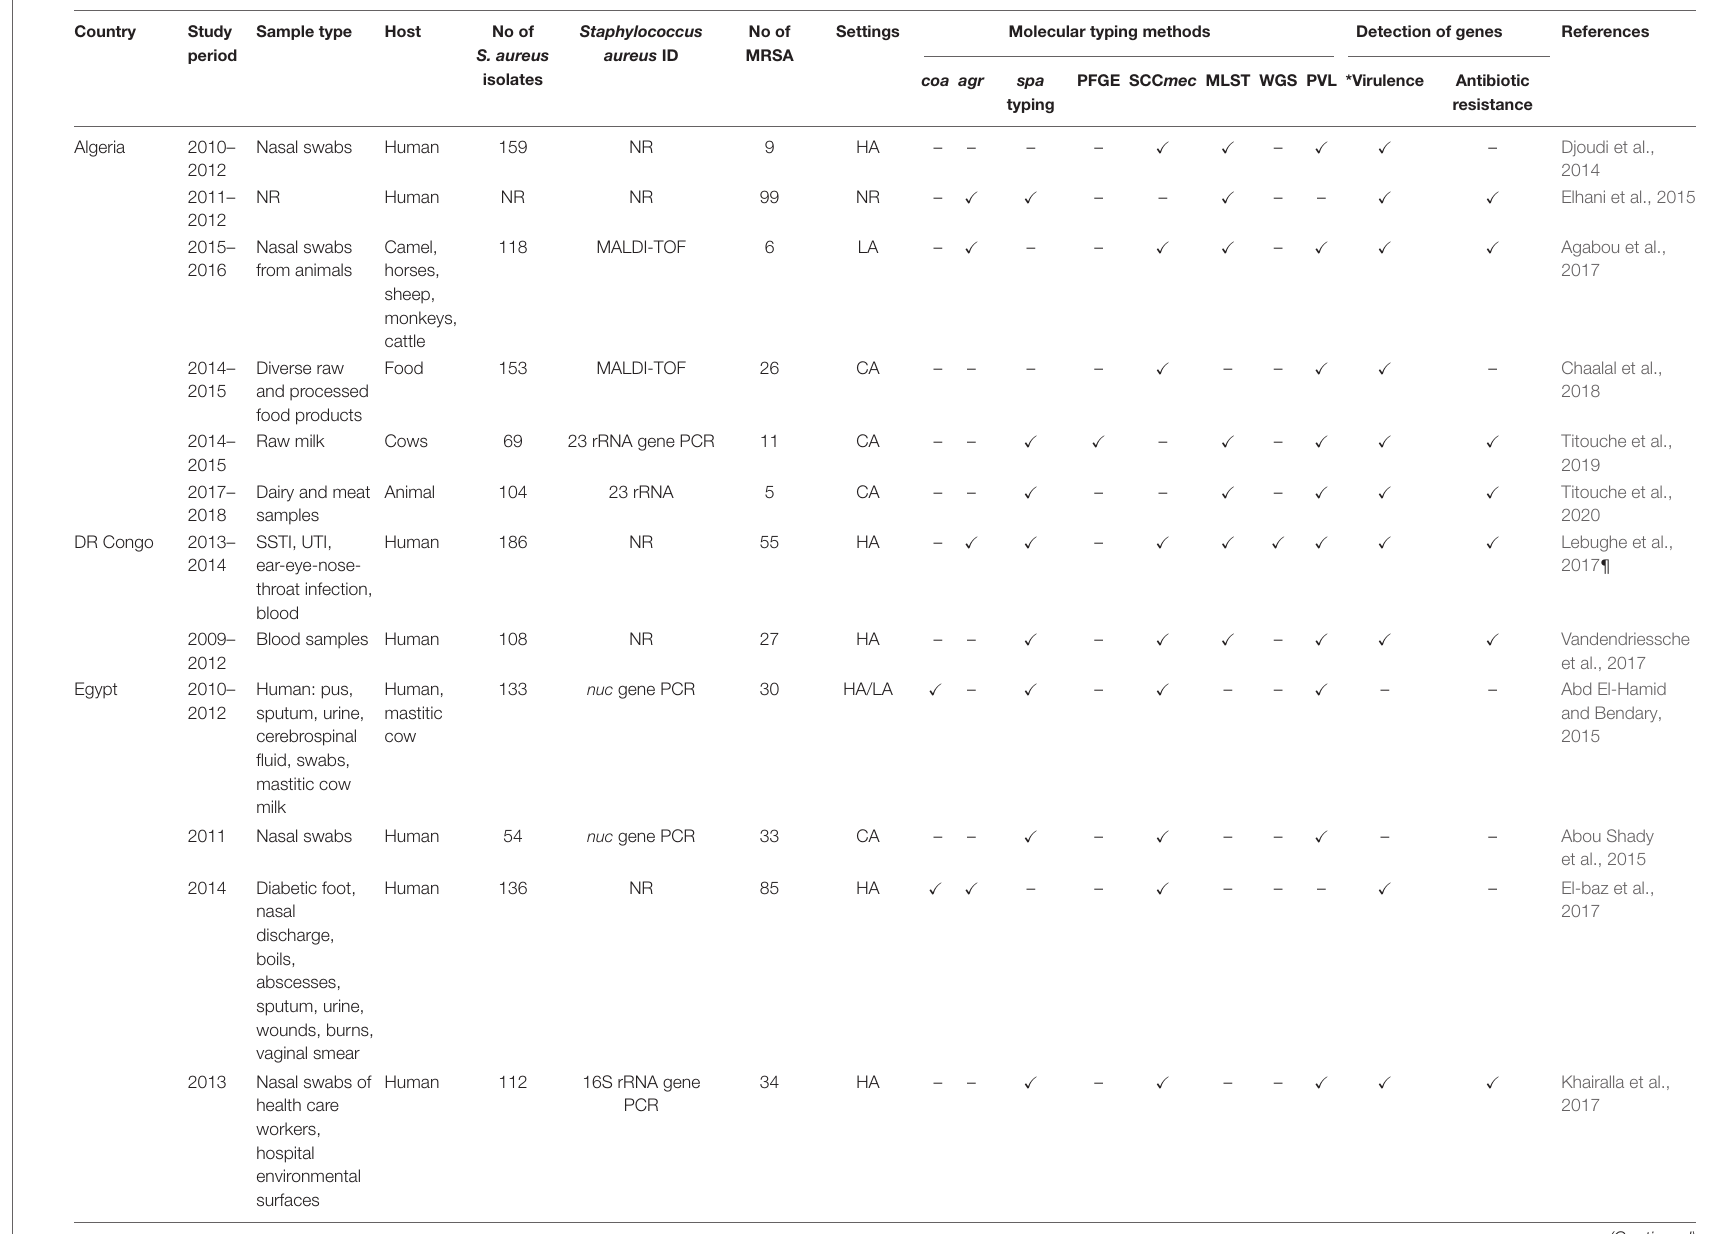
TABLE 1 | Summary of the characteristics of eligible articles on the molecular epidemiology of methicillin-resistant Staphylococcus aureus (MRSA) in Africa.